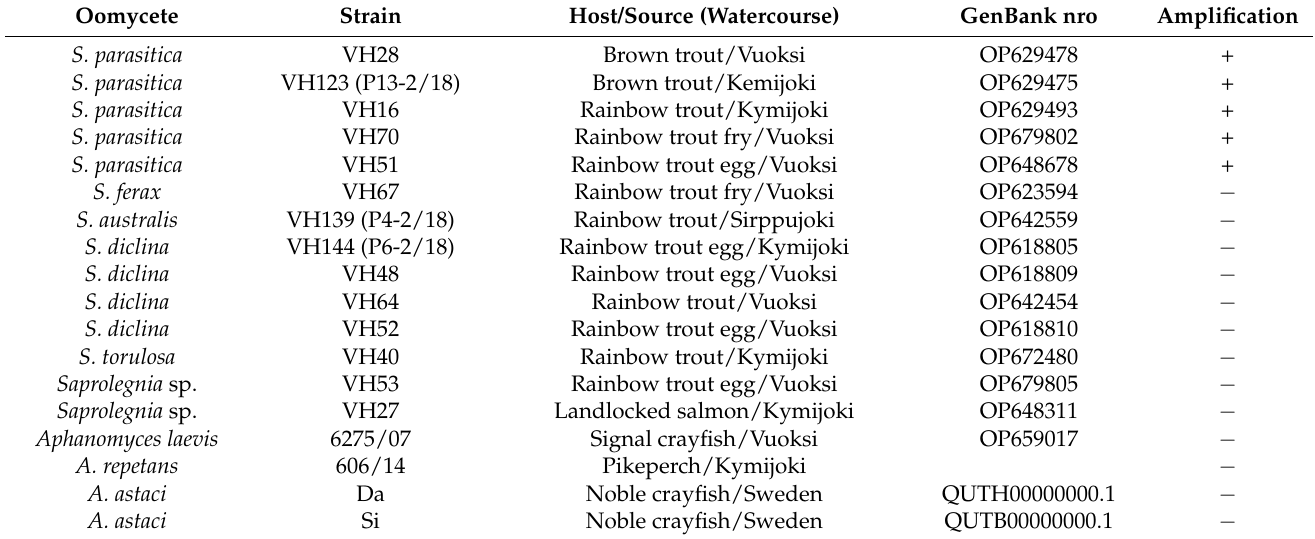
Table 1. Oomycetes from the oomycete culture collection of the Finnish Food Authority used to test the specificity and sensitivity of the Saprolegnia parasitica primers and